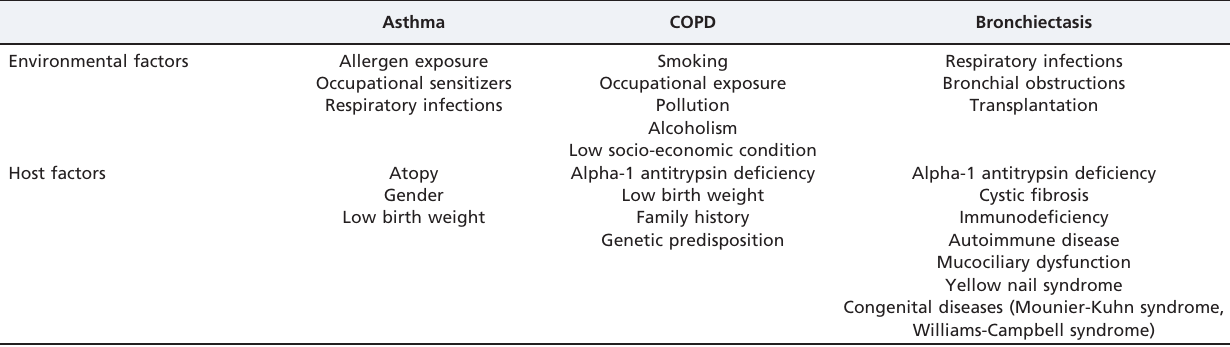
Table 1 - Risk factors for asthma, COPD and